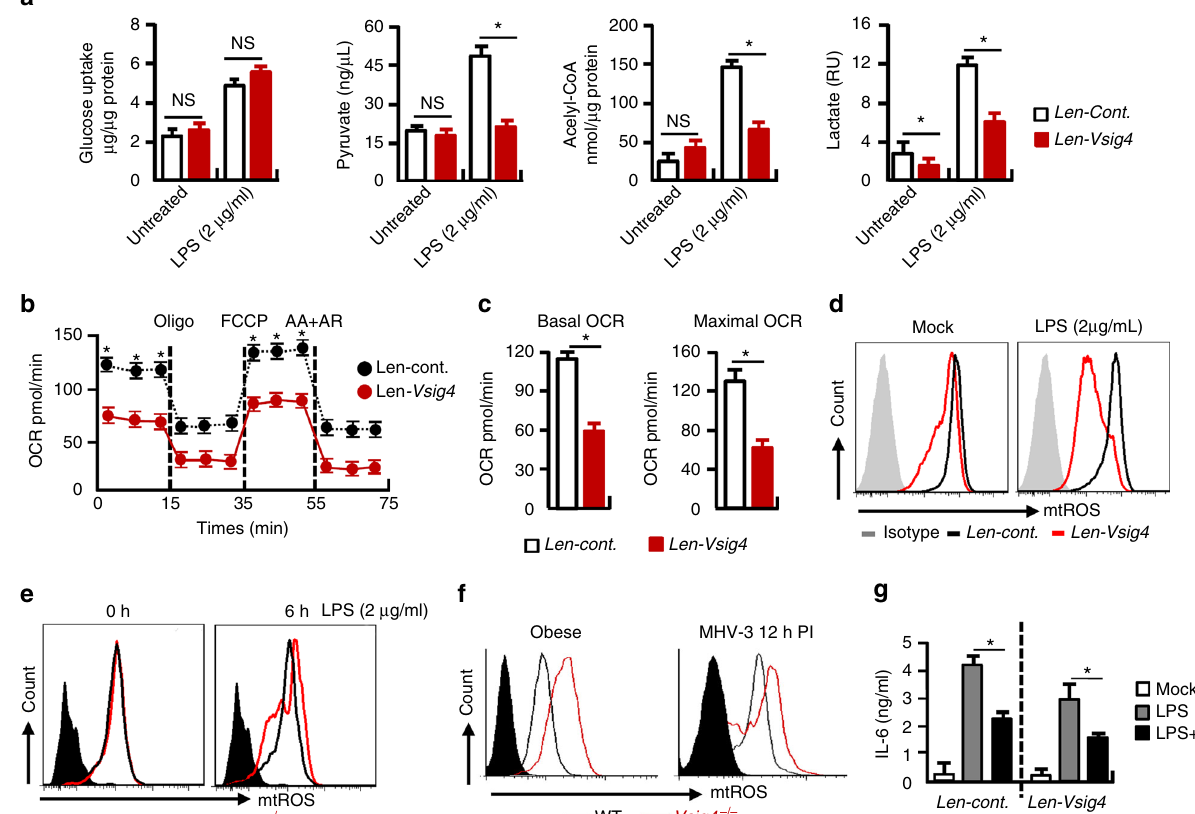
Fig. 4 VSIG4 reprograms pyruvate metabolism and mtROS generation. VSIG4 + RAW264.7 cells and their controls were treated with LPS (2 μ g/ml) for 6 h. a Colorimetric/Fluorometric assay of glucose uptake, pyruvate, Acelyl-CoA and Lactate levels, n = 5 per group. b OCR of LPS-treated RAW264.7 cells by Seahorse XFp assay. OCR detected before and after sequential treatment with ATP synthase inhibitor Oligo, mitochondrial uncoupling agent FCCP, ETC inhibitors AA+AR at indicated times, n = 5 per group. c OCR at basal and maximal levels of the indicated conditions was plotted in bar graphs. d mtROS secretion was detected by fl ow cytometry. e Vsig4 − / − PEMs and the WT controls were treated with LPS for 0 and 6 h, and mtROS secretion was detected by fl ow cytometry. f mtROS secretion from ATMs of obese mice and PEMs from 12 h of MHV-3-infected animals was compared by fl ow cytometry. g RAW264.7 cells were treated with mtROS inhibitor DPI (10 μ M) for 48 h in advance, cells were then added with LPS (2 μ g/ml) for an additional 6 h, IL-6 in the supernatant was detected by ELISA. Error bar, s.e.m. * p < 0.05 and NS, p > 0.05 (Student ’ s t -test). Data are representative of three